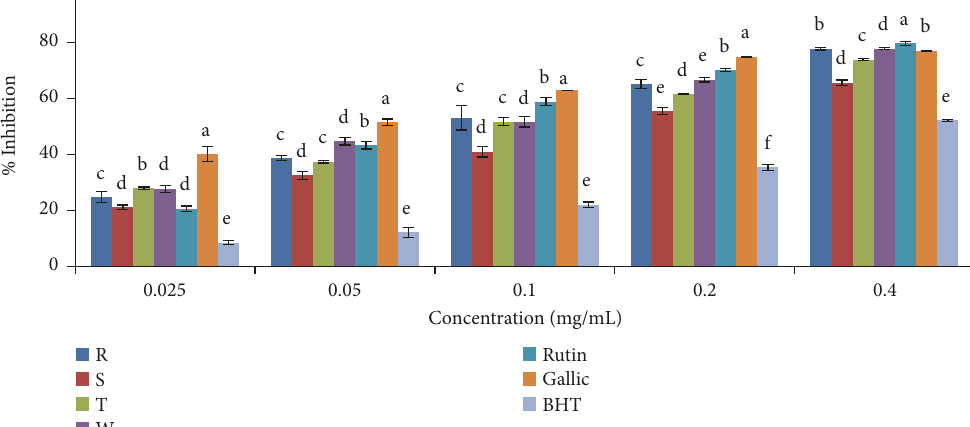
Figure 8: Total antioxidant capacity of ethanolic extract of the four varieties of Capsicum species. Values are mean ± SD of three replications. Set of bars having different letters are significantly different at (p < 0.05). R= C. annuum var. abbreviatum , S= C. annuum var. acuminatum ,